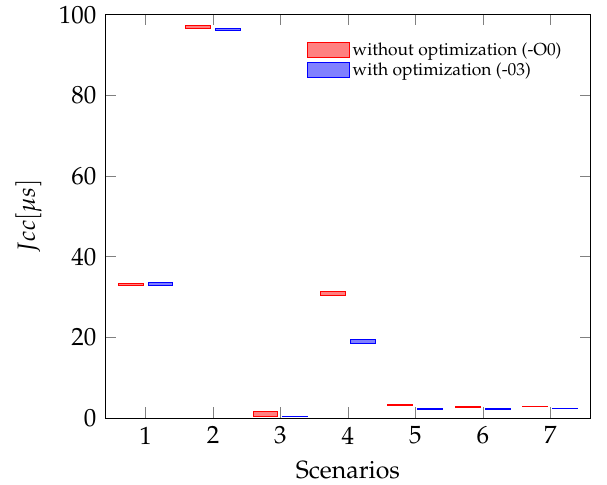
Figure 15. Confidence intervals for Jcc with and without code